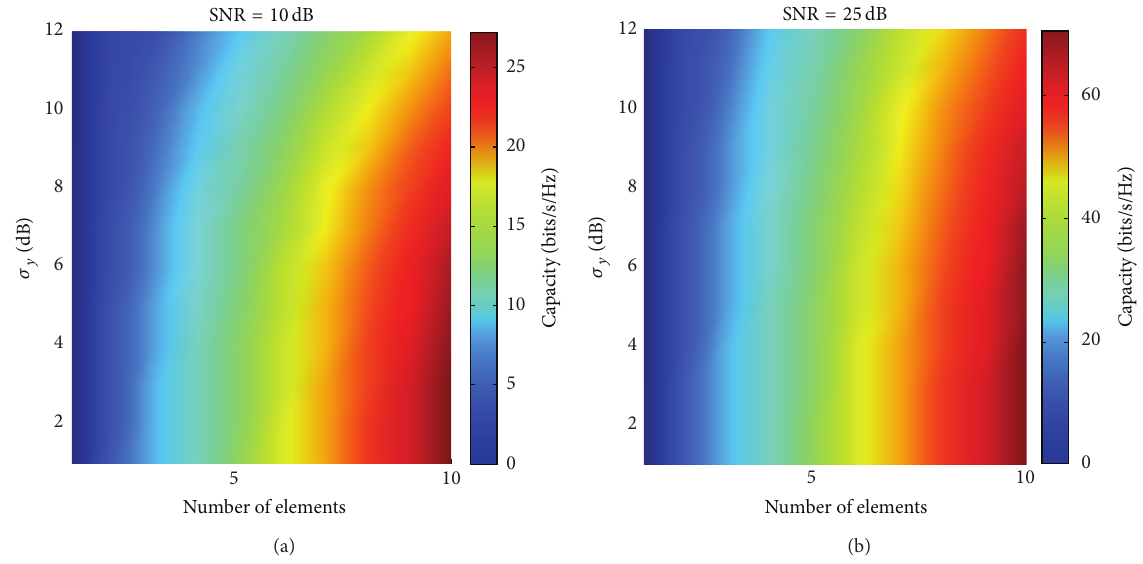
Figure 6: Capacity versus the number of elements versus 𝜎 shadowing, on a 3D contour plot, (a) with SNR = 10 dB and (b), SNR = 25 dB.